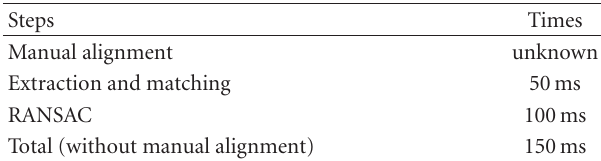
Table 1: Computation times for the semiautomated initialization